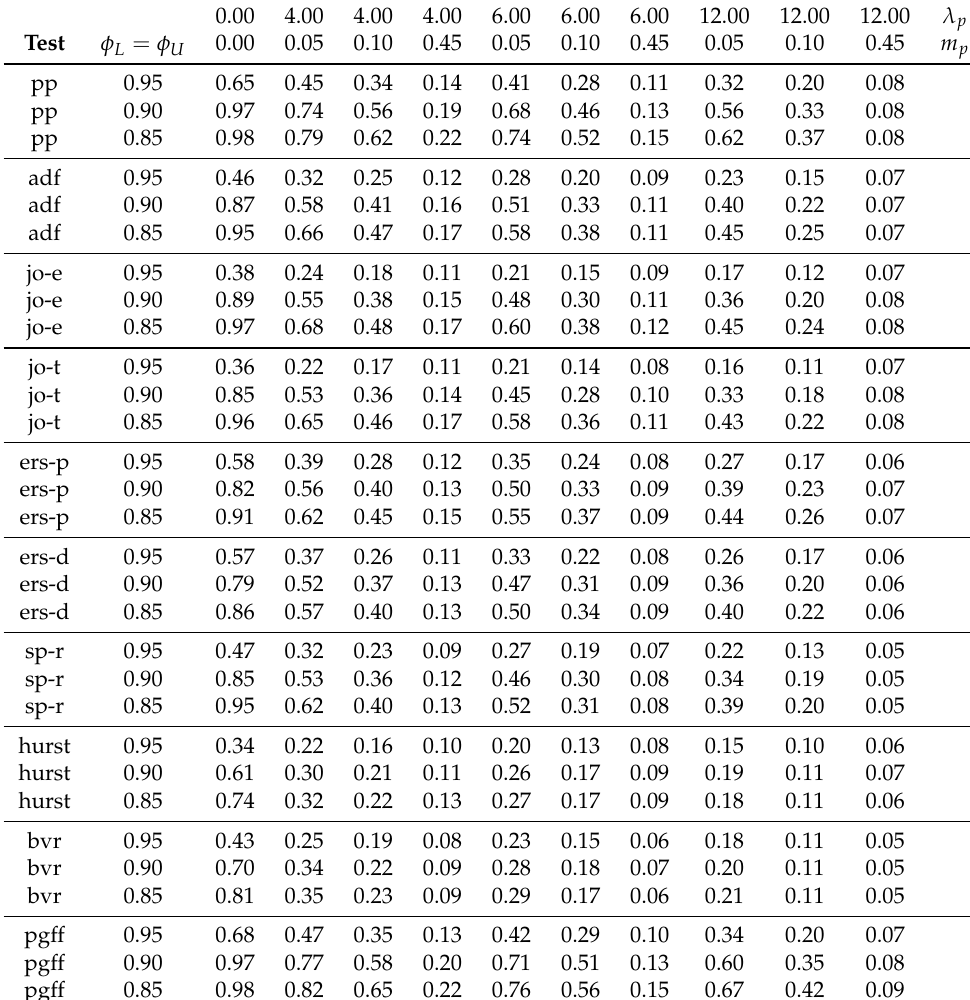
Table 15. Power of cointegration tests for Monte Carlo settings of Type VI, as described in Subsection